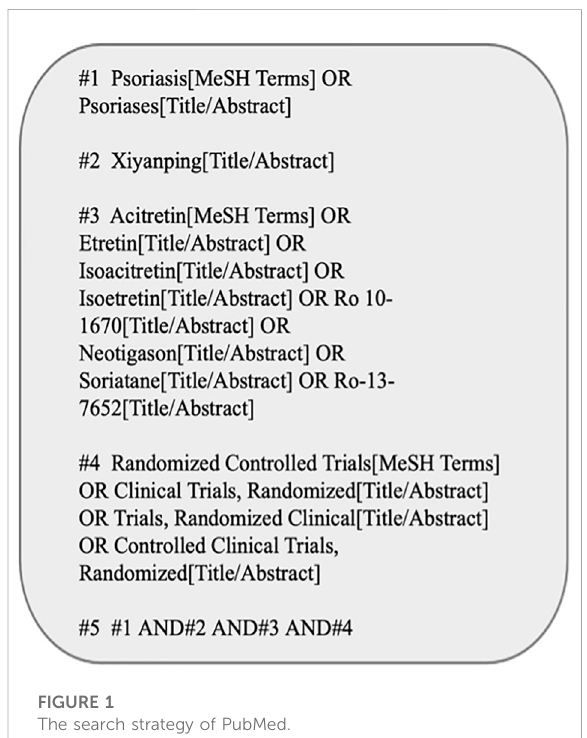
FIGURE 1 The search strategy of